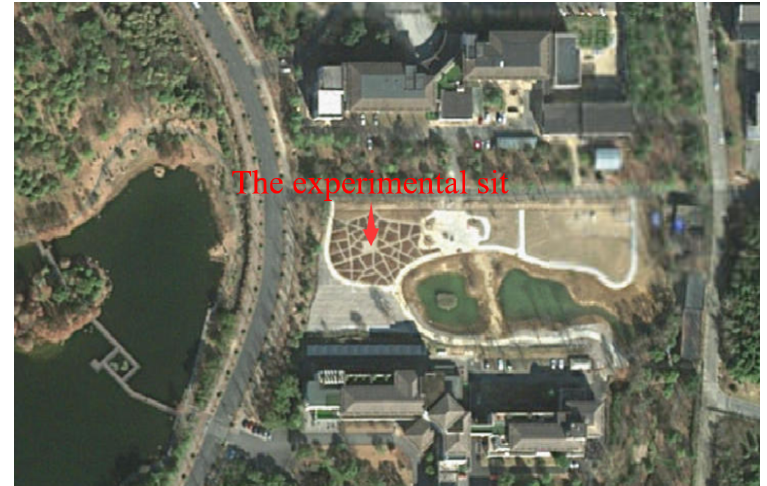
Figure 10. The satellite image of the experimental